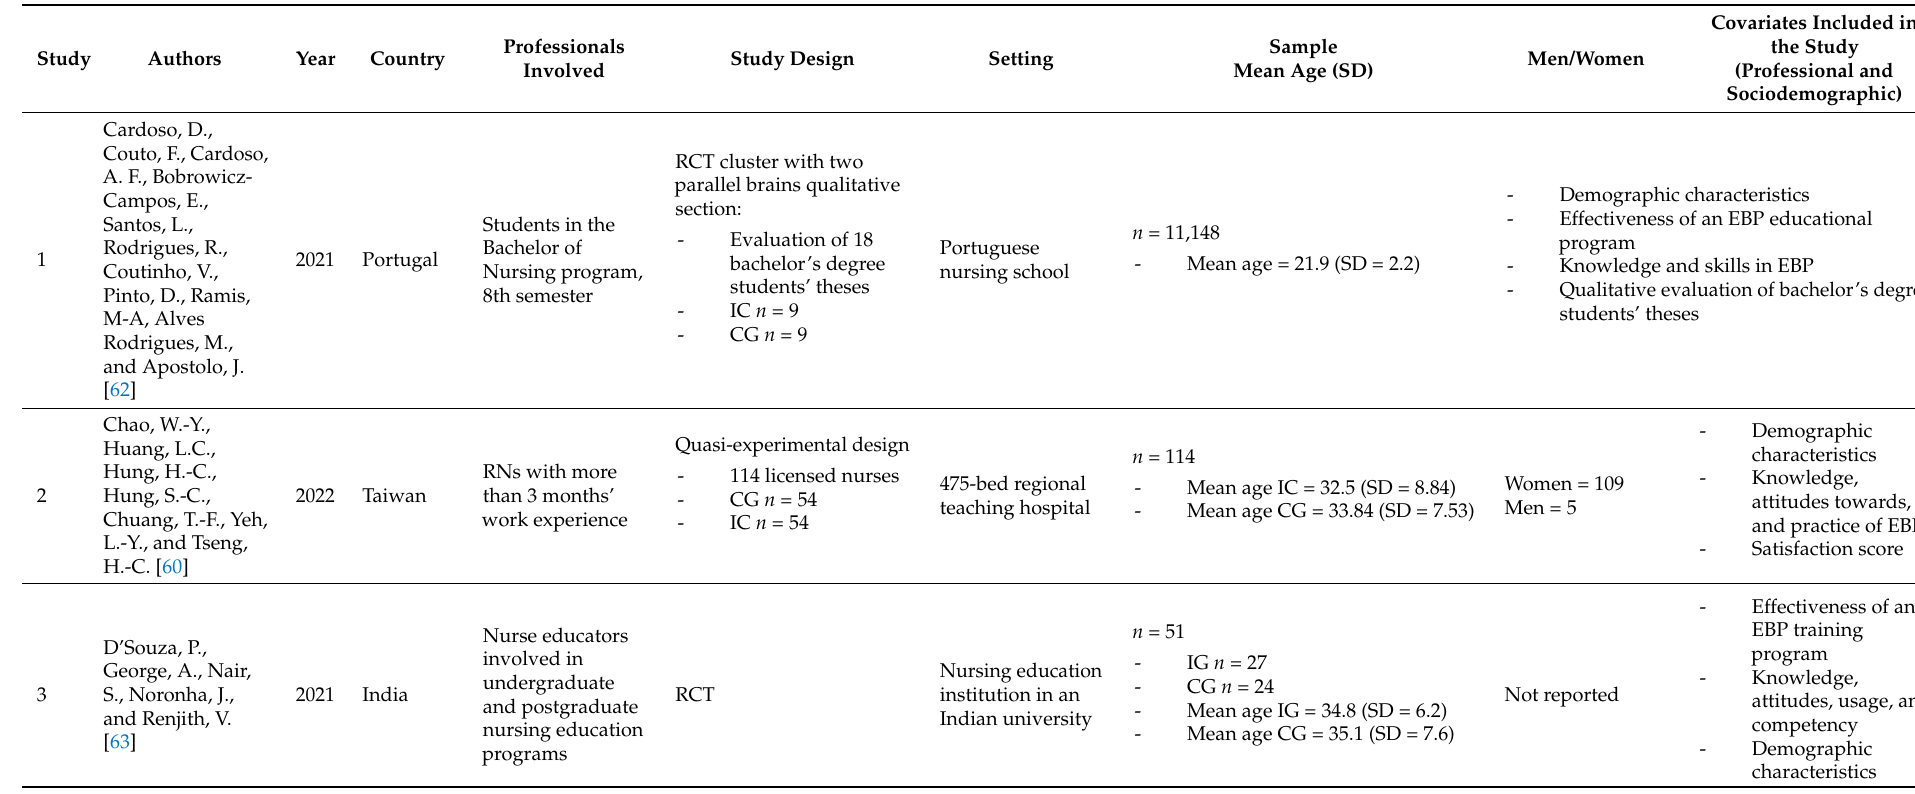
Table 1. Characteristics of the studies retained ( n =